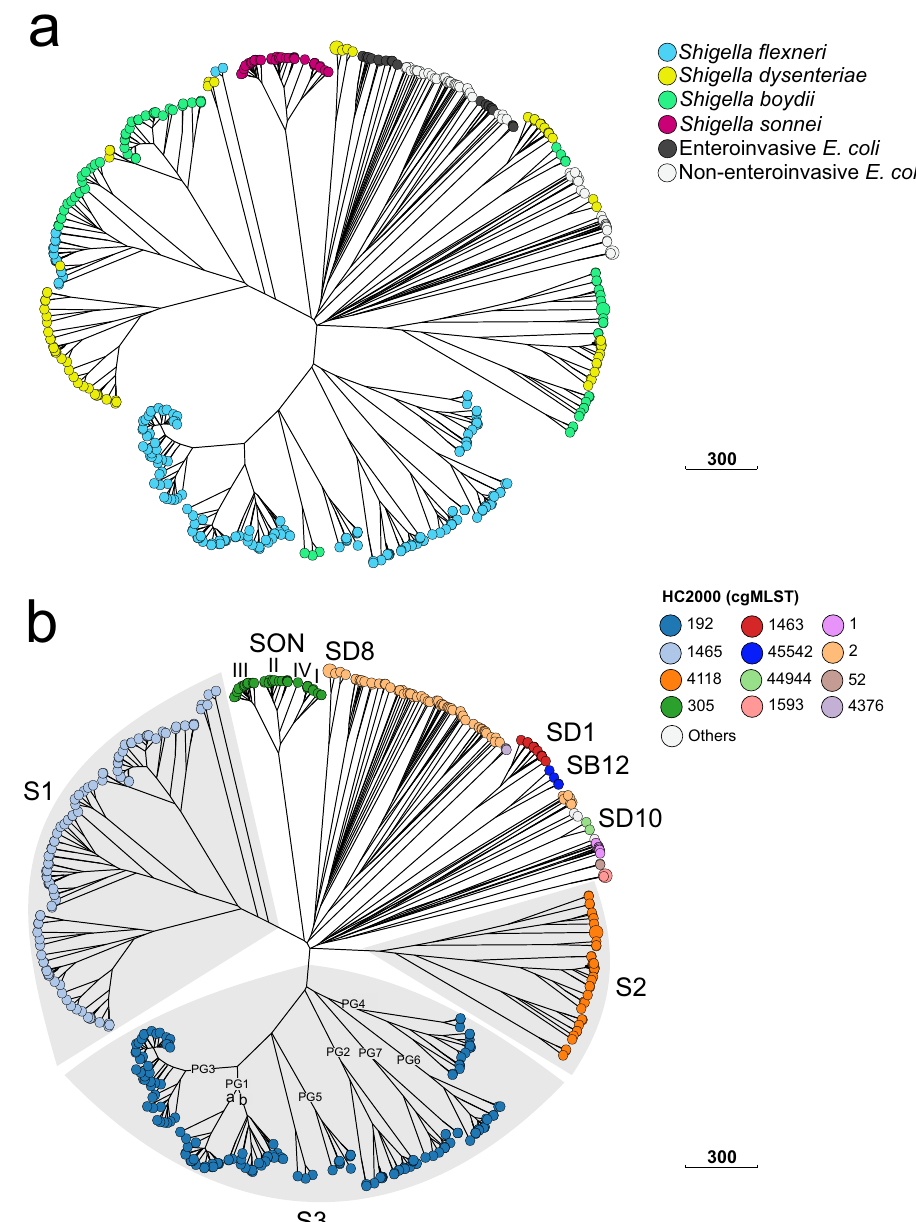
Fig. 1 Population structure of Shigella spp. based on the cgMLST allelic differences between 493 Shigella and E. coli reference genomes. a A NINJA neighbour-joining (NJ) GrapeTree with tree nodes colour-coded by Shigella serogroup and E. coli pathovar. b A NINJA NJ GrapeTree with tree nodes colour- coded by HC2000 data. HC2000 clusters with fewer than two isolates are represented by white nodes. The different Shigella cgMLST clusters are labelled. For the SON cluster, the different genomic lineages of S. sonnei are indicated with Latin numerals. For the S. fl exneri serotypes in cluster S3, the phylogenetic groups (PG1 to PG7) identi fi ed by Connor and coworkers 2 are also indicated. The scale bar indicates the number of cgMLST allelic differences. The interactive version of the tree is publicly available from http://enterobase.warwick.ac.uk/ms_tree?tree_id = 55118 and